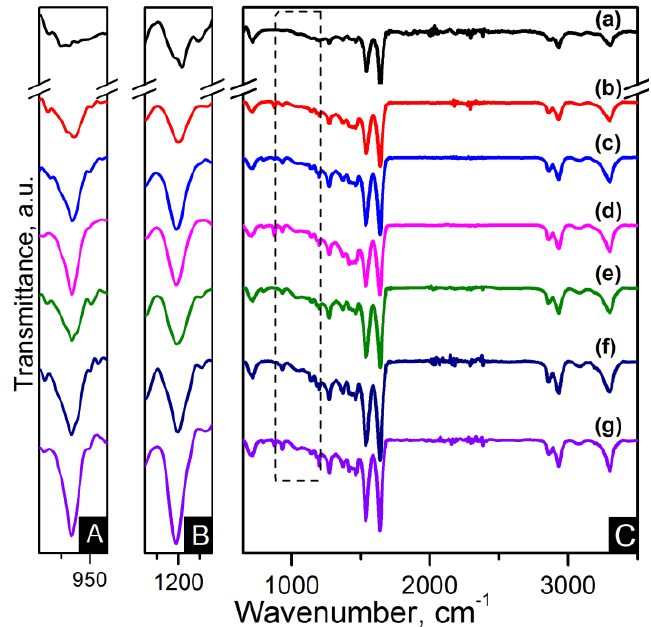
Figure 4. FTIR spectra of ( A ) zoom-in of ~935 cm − 1 peak; ( B ) zoom-in of ~1200 cm − 1 peak and ( C ) region of 900–3500 cm − 1 of the samples: ( a ) pure PA66; ( b ) PA66/01CNTs; ( c ) PA66/05CNTs; ( d ) PA66/10CNTs; ( e ) PA66/01OCNTs; ( f ) PA66/05OCNTs and ( g ) PA66/10OCNTs.